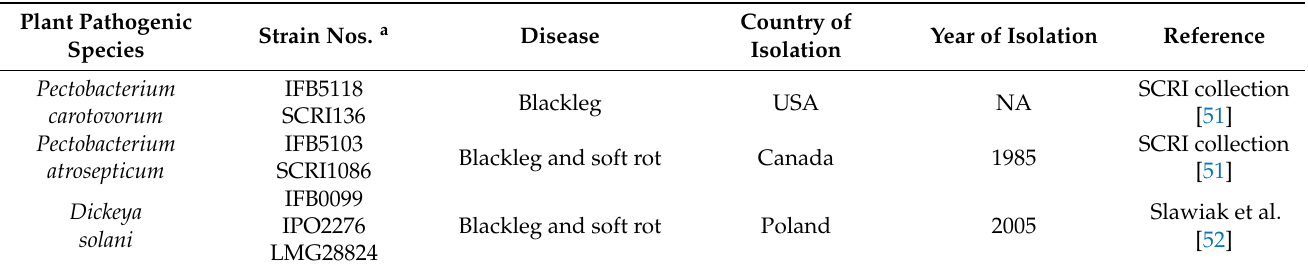
Table 1. Plant pathogenic bacteria utilized in this